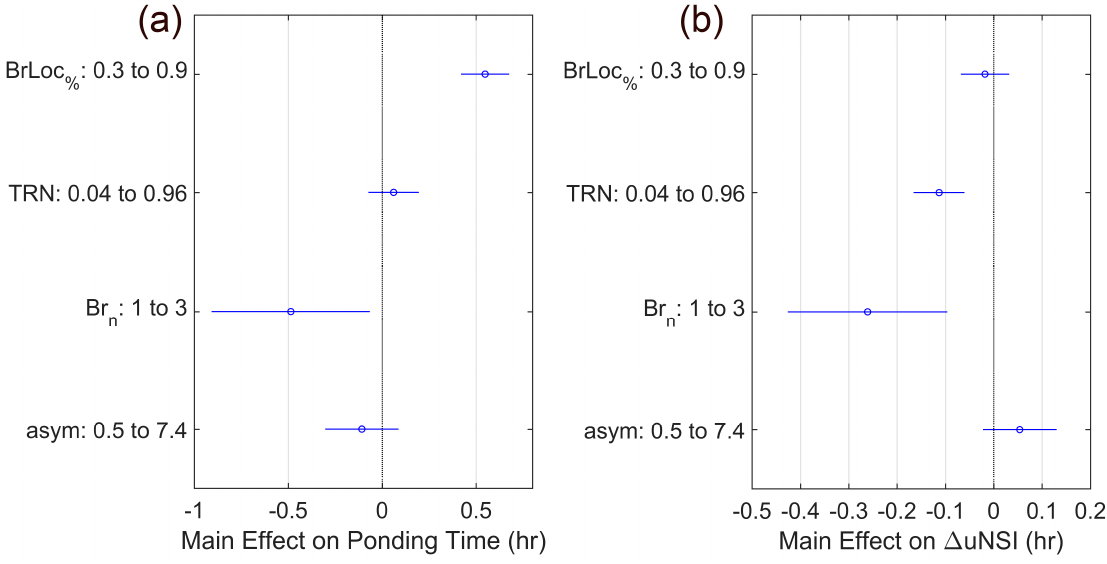
Figure 8. Estimated effects on the response (ponding time ( a ) and ∆ uNSI ( b )) from changing each predictor value (percentage of the total storm period that has occurred at the start of the heaviest burst—BrLoc % , number of bursts—Br n , hyetograph triangularity—TRN, asymmetry of the storm—asym), averaging out the effects of the other predictors. Values of the predictors are chosen automatically to produce a relatively large effect on the response.